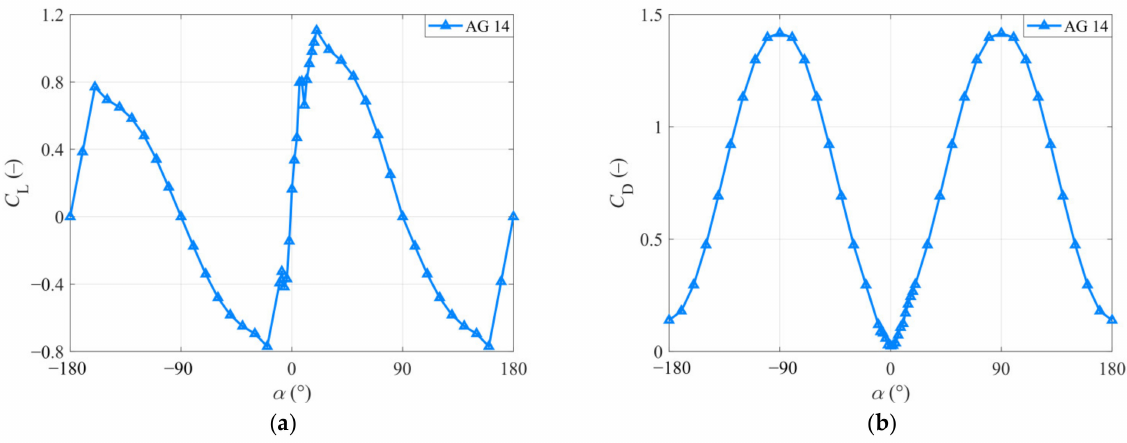
Figure 4. The aerodynamic performance of AG 14 airfoil at the model Reynolds number. ( a ) The lift coefficient. ( b ) The drag